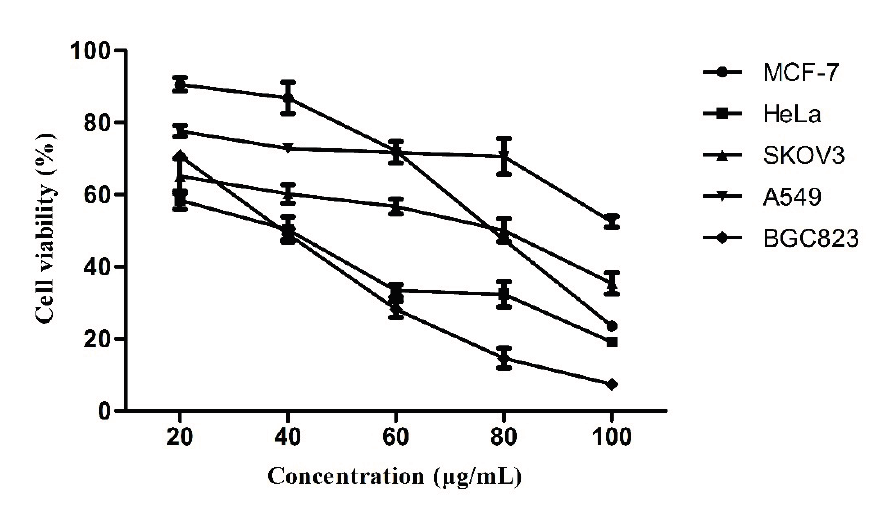
Figure 2. Effect of the HP essential oil on cell viability of five cancer cell lines. Cells were treated with vehicle alone (0.5% DMSO) and specified concentrations of the essential oil in 0.5% DMSO for 24 h; cell viability was determined by the MTT assay as detailed in Section 2. The values are represented as the percent of viable cells, with vehicle-treated cells regarded as 100% viable. Each point represents the mean of the values obtained from three independent